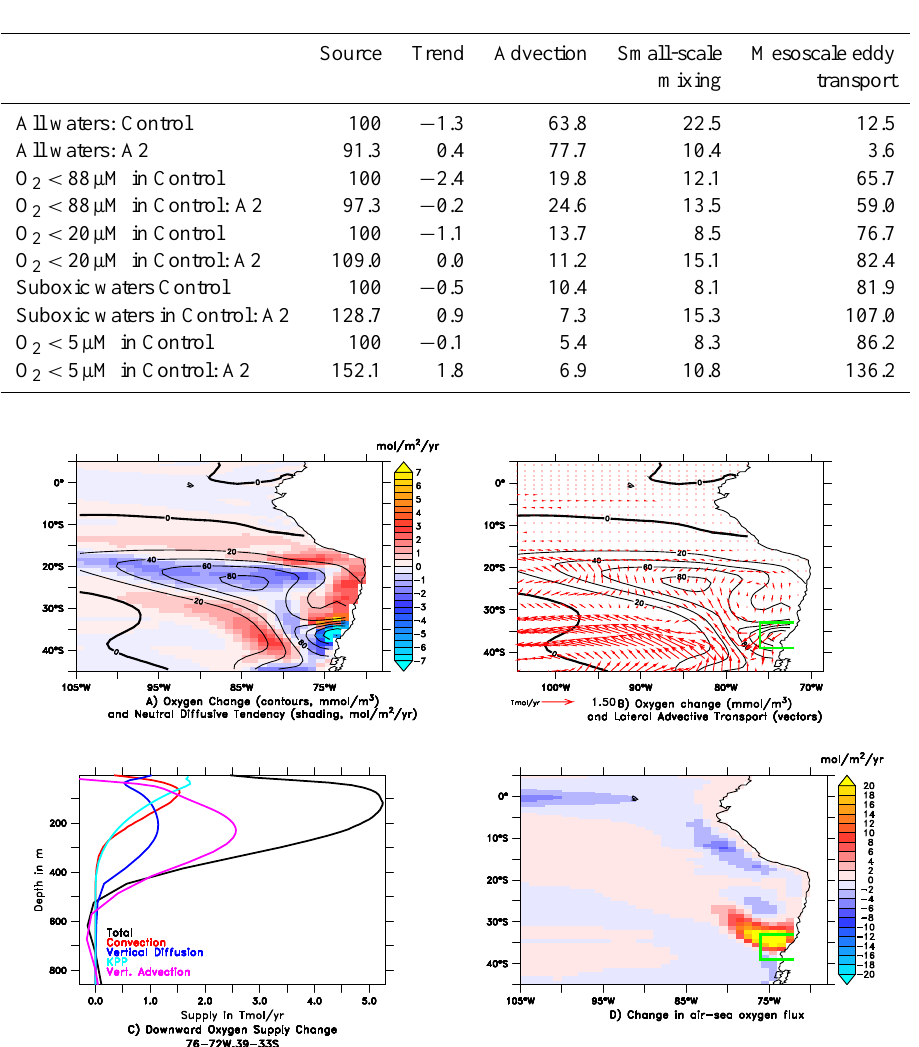
Table 2. O 2 budget for the region 40 ◦ S–5 ◦ N, 300–1500m that shows an increase in oxygen concentration in Fig. 2. A2 run is averaged from years 2281–2300. All terms are given as a percentage of the oxygen consumption over the relevant volume in the control run integrated from years 221–240. The volume used to compute budgets in the A2 run comprises exactly the same points as those used to compute budgets in the control run.